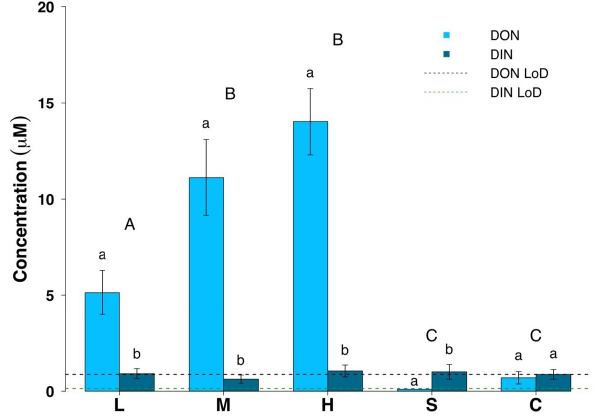
Figure 3. Dissolved organic nitrogen (DON) and dissolved in- organic nitrogen (DIN) concentrations for all surface habitats (mean ± SE, n = 19 for L, M, H, n = 10 for S and n = 14 for C). L – ice with low visible impurities, M – ice with medium visible impurities, H – ice with high visible impurities, S – supraglacial stream water and C – cryoconite hole water. The LoD line depicts the limit of detection of the instrument. Uppercase letters denote homogeneous subsets derived from post hoc Tukey HSD analysis on a significant one-way ANOVA in relation to the dissolved nitro- gen phase. Lowercase letters denote t test comparisons in relation to habitat type.